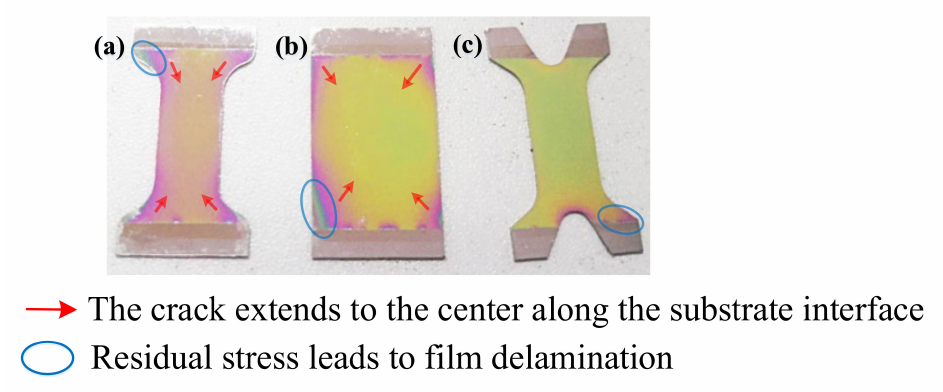
Figure 2. ( a – c ) Crack propagation in TiN/Si 3 N 4 film system on 304SS substrates with different